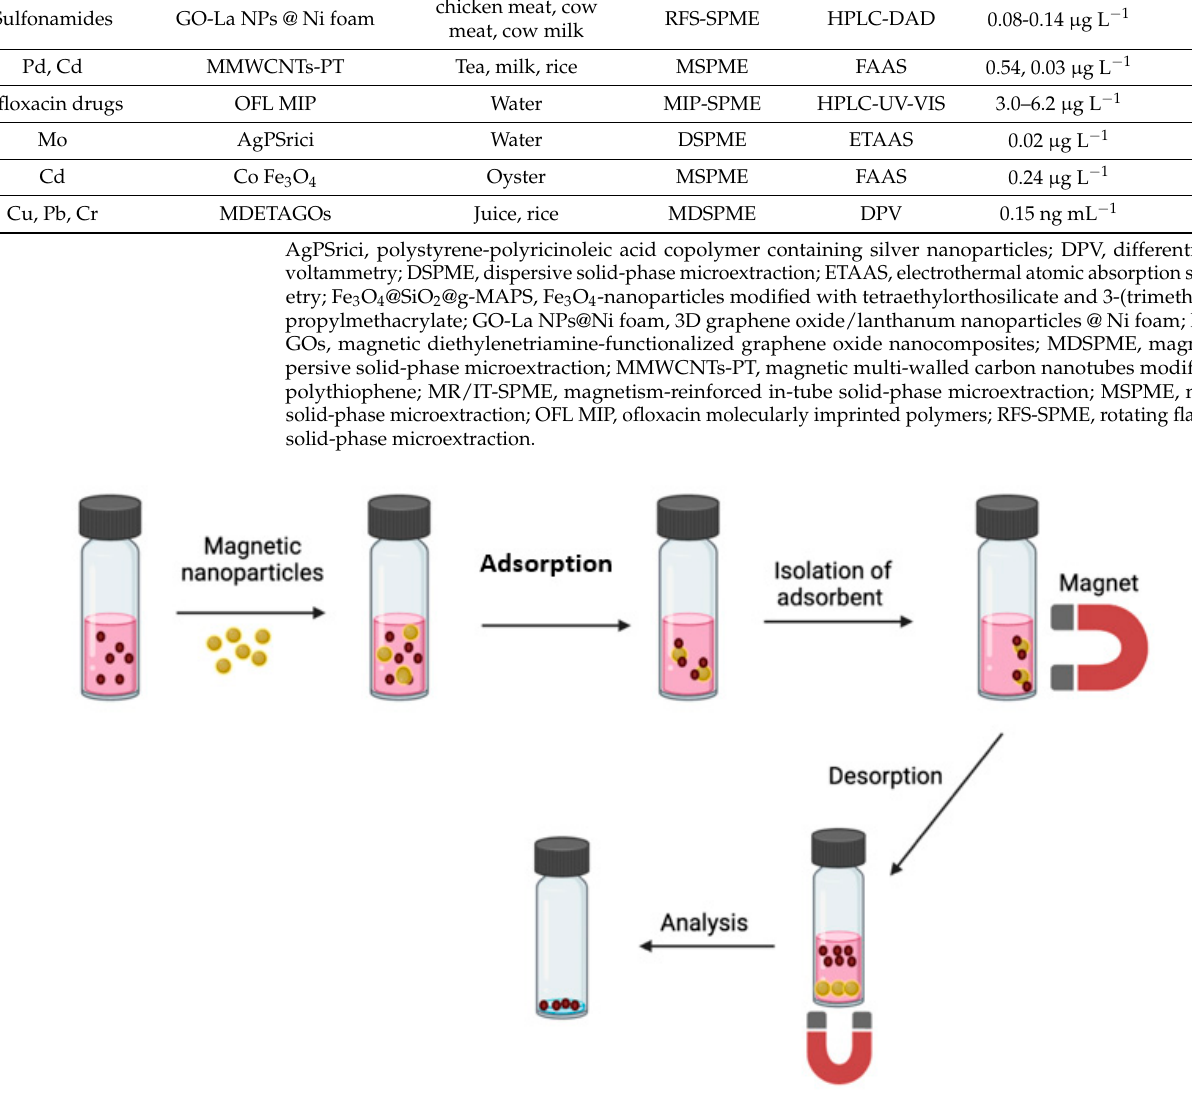
Figure 3. A sorbent is placed in the solution containing the target analytes. The analytes have direct contact with the sorbent NPs, which causes selective adsorption on the solid surface of the sorbent. A magnetic field in the solution is used to separate the main analyte from the solution. such as Fe 3 O 4 [33]. The magnetic core of MNPs is not fully selective. To overcome these